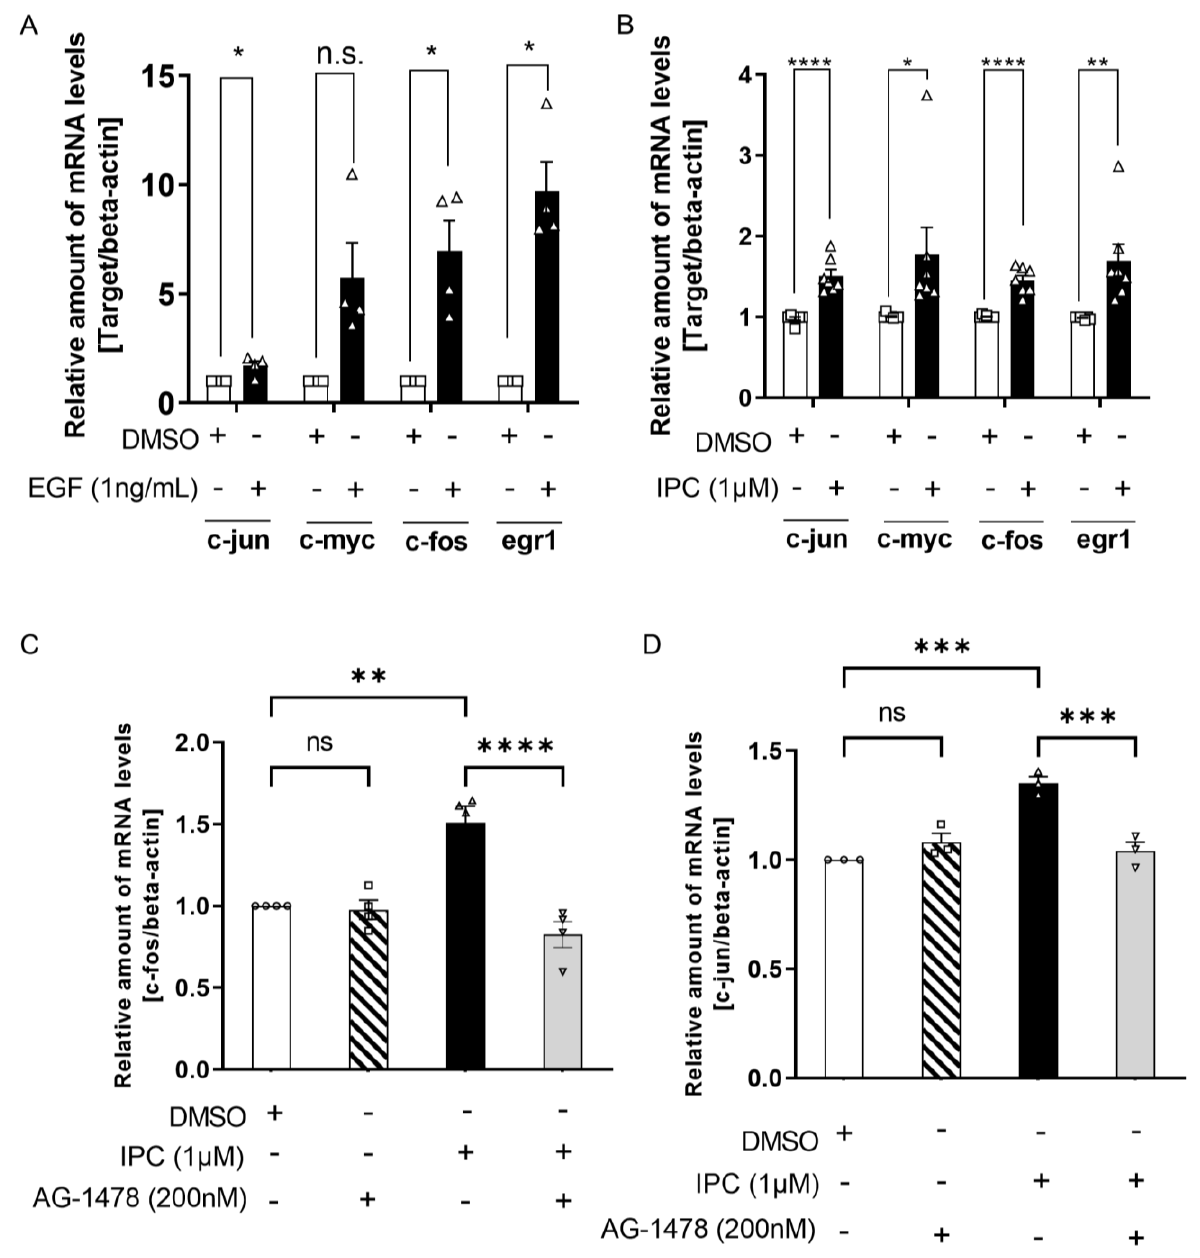
Figure 3. IPC induces the expression of genes related to cell growth and proliferation. ( A ) Measuring the effect of EGF on mRNA level of genes related to cell growth and proliferation. HaCaT cells were treated with EGF (1 ng/mL) for 1 h. Total RNA extracted from HaCaT cells were reverse-transcribed into cDNA, and were subjected to real-time quantitative polymerase chain reaction (RT-qPCR). mRNA levels of c-jun , c-myc , c-fos , and egr1 were measured. mRNA level of beta-actin was used for normalization ( n = 4). n.s., not significant, * p < 0.05; unpaired Student’s t test; error bars indicate SEM. ( B ) Measuring the effect of IPC (1 μM) on mRNA level of genes related to cell growth and proliferation. HaCaT cells were treated with IPC for 1 h. Similarly to ( A ), mRNA levels of c-jun , c-myc , c-fos , and egr1 were measured. The mRNA level of beta-actin was used for normalization ( n = 4). n.s., not significant, * p < 0.05, ** p < 0.01, **** p < 0.0001; unpaired Student’s t test; error bars indicate SEM. ( C , D ) Measuring the effect of IPC on c-fos ( C ) and c-jun ( D ) mRNA levels after blocking EGFR signaling. HaCaT cells were treated with AG-1478, an EGFR antagonist, before being treated with IPC. mRNA levels of c-fos and c-jun were measured through RT-qPCR. The mRNA level of beta-actin was used for normalization. The experiment was repeated four times for ( C ) and three times for ( D ). n.s., not significant, ** p < 0.01, *** p < 0.001, **** p < 0.0001; ordinary one-way analysis of variance (ANOVA) with Tukey’s multiple comparison test; error bars indicate SEM.